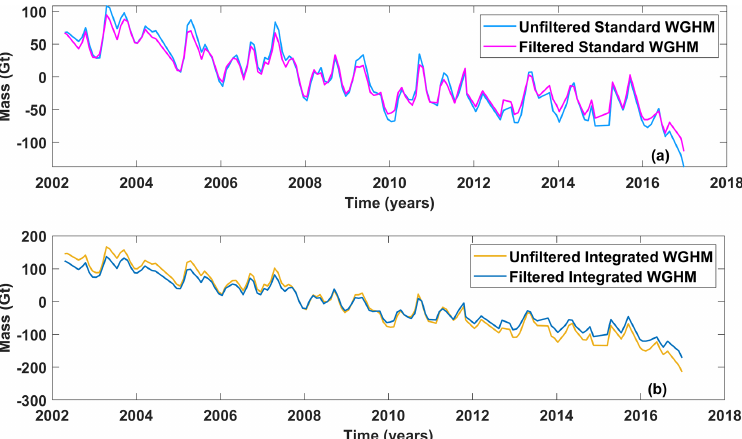
Figure 9. Unfiltered and filtered basin-averaged time series from (a) standard WGHM and (b) integrated WGHM version. Note the different y axis